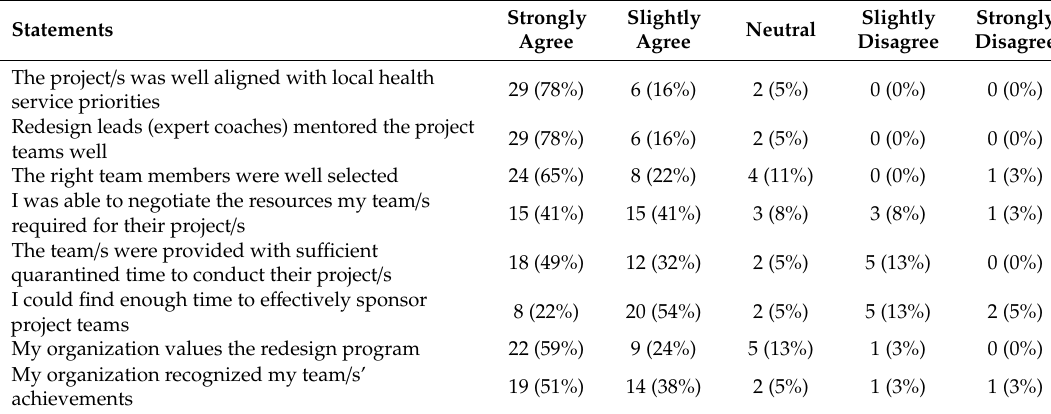
Table 6. Perceptions of executive sponsors regarding organizational support ( N = 37).